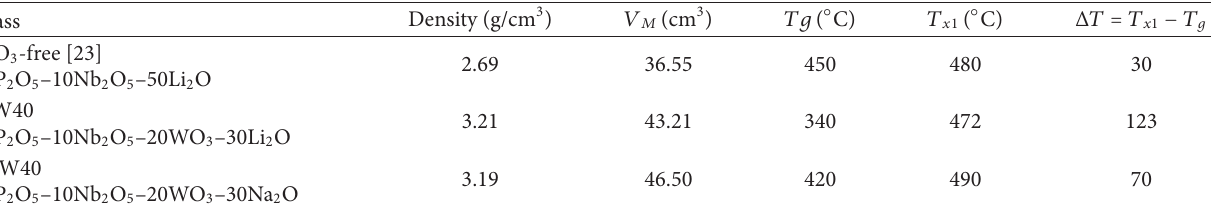
more depolymerized and the ultraphosphate structure com- posed of cross-linked Q units (O/P = 2.5) changes to ( a ) the chain-like metaphosphate structure made up of Q units 3 (O/P = 3.0) to ( b ) the pyrophosphate, Q , structure (O/P = 2 3.5) and �nally to ( c ) the orthophosphate structure consisting 𝑥 of isolated Q units (O/P = 4.0). In all of the AW-40 glasses of the present work, the O/P ratio is 4.25, so the network 0 structure is expected to be dominated by orthophosphate Q groups. For instance, the structure of NbOPO consists of Q units sharing corners with niobium NbO units. In 0 agreement with the structural O/P ratio, the XRD patterns 0 and in the NaW-40 sample in the monoclinic structure. e formation of different NbOPO structures can be related 4